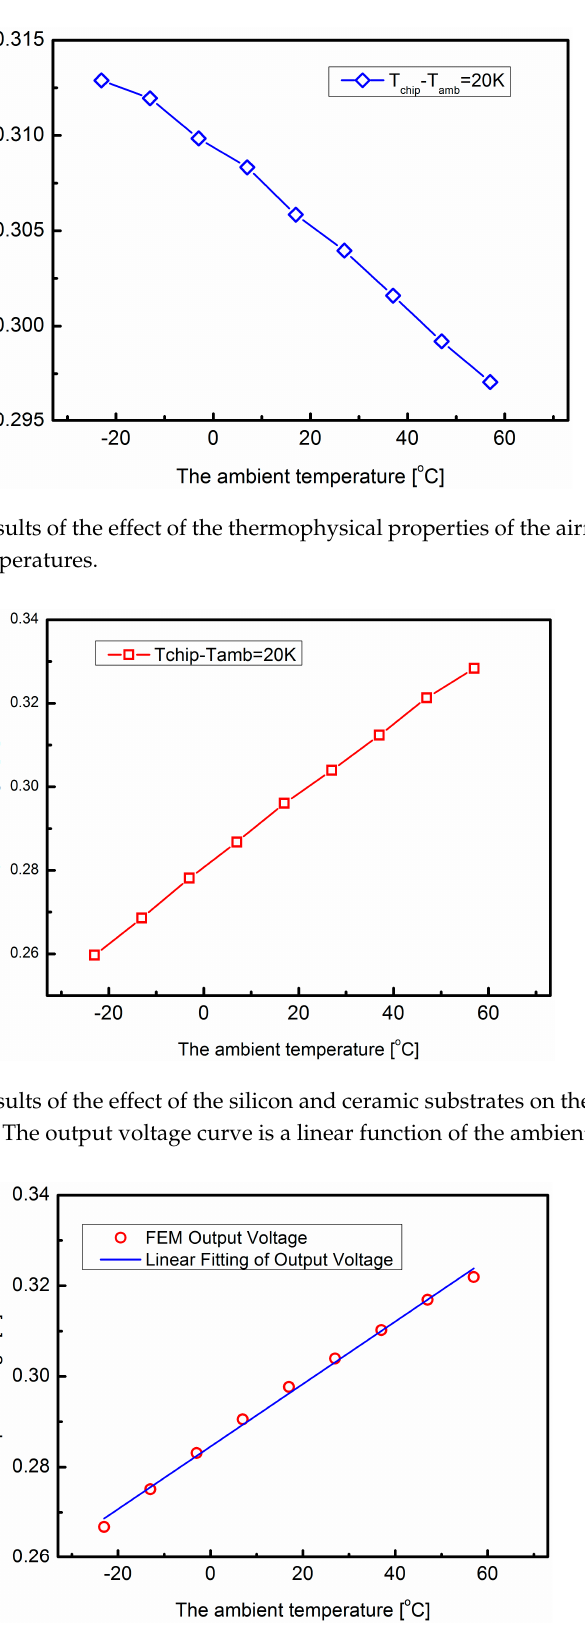
Figure 7. Simulation results of the output voltage of the wind sensor. The output of the wind sensor is a linear function of temperature.